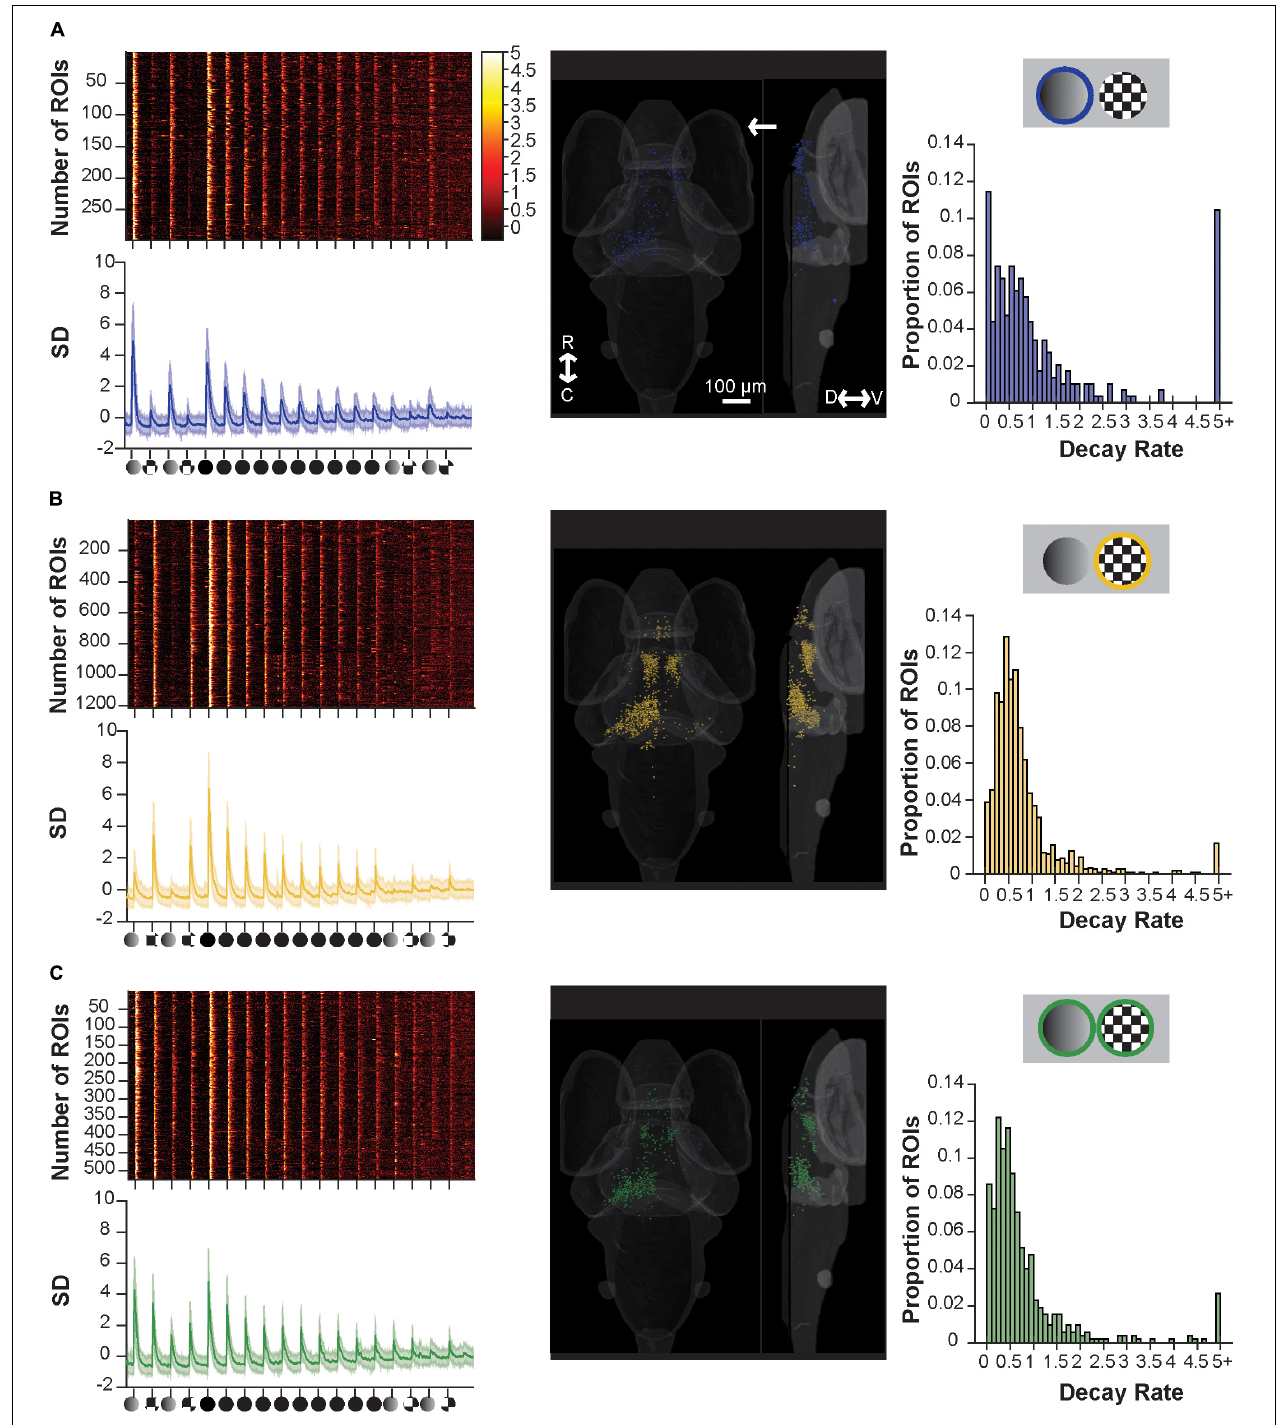
FIGURE 4 | Component sensitive responses and their associated rates of habituation. (A) A raster plot (top left), average trace with S.D. shaded (bottom left), transverse and lateral spatial distributions (middle), and histogram of their rate of decay as modeled from fitting with an exponential decay curve (right) for ROIs responsive to dim and full loom stimuli. ROIs with responses ≥ 5.0 are pooled. Response strengths are shown in S.D., and the arrow shows the position of the stimulus presentation. (B) Showing the same information as above but for ROIs responsive to checkerboards and full loom stimuli, (C) same as above but for ROIs responsive to dims, checkerboards and full loom stimuli. R, rostral; C, caudal; D, dorsal; V, ventral.